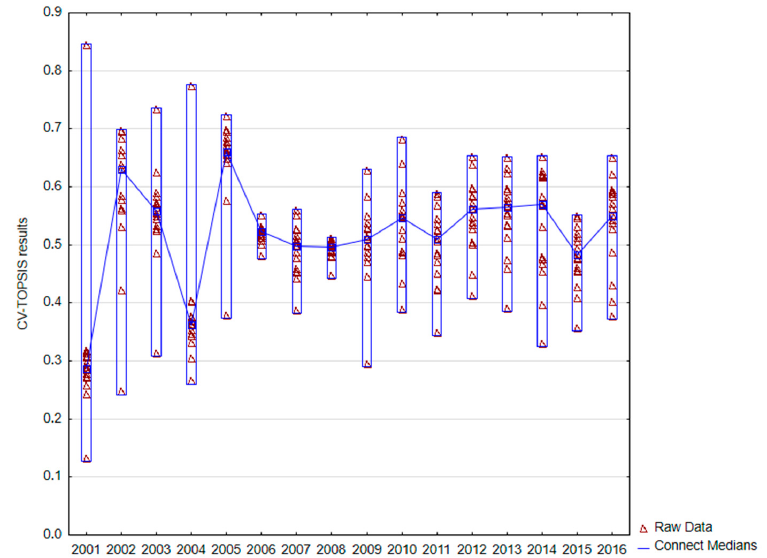
Figure 3. Total results of CV-TOPSIS method for period of years 2001–2016 (variant II.). Similar to the variant with included Transport Company of City Prague, median values conformance wasn´t confirmed (W = 81,247, p ≤ 0.01), which was indicated by the di ff erences in comparison of years 2001 and 2008 as an example. A significant linear relation ( α = 0.05) between the results in particular years is depicted on the Table 4, confirming conclusions drawn in the variant I. Table 4. Confirmed linear relation between results of CV-TOPSIS method for period of years 2001–2016 (variant II.).